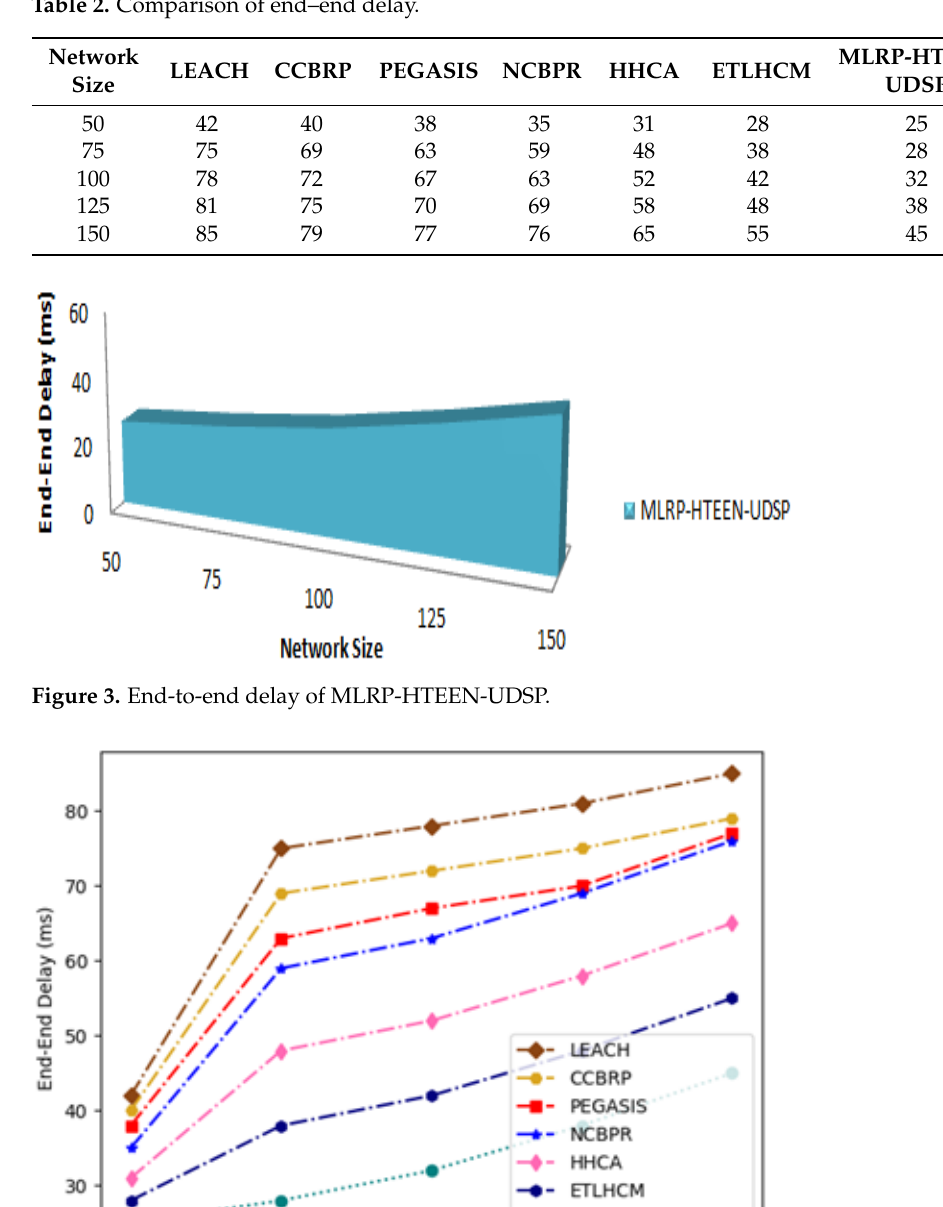
Table 2. Comparison of end–end delay.